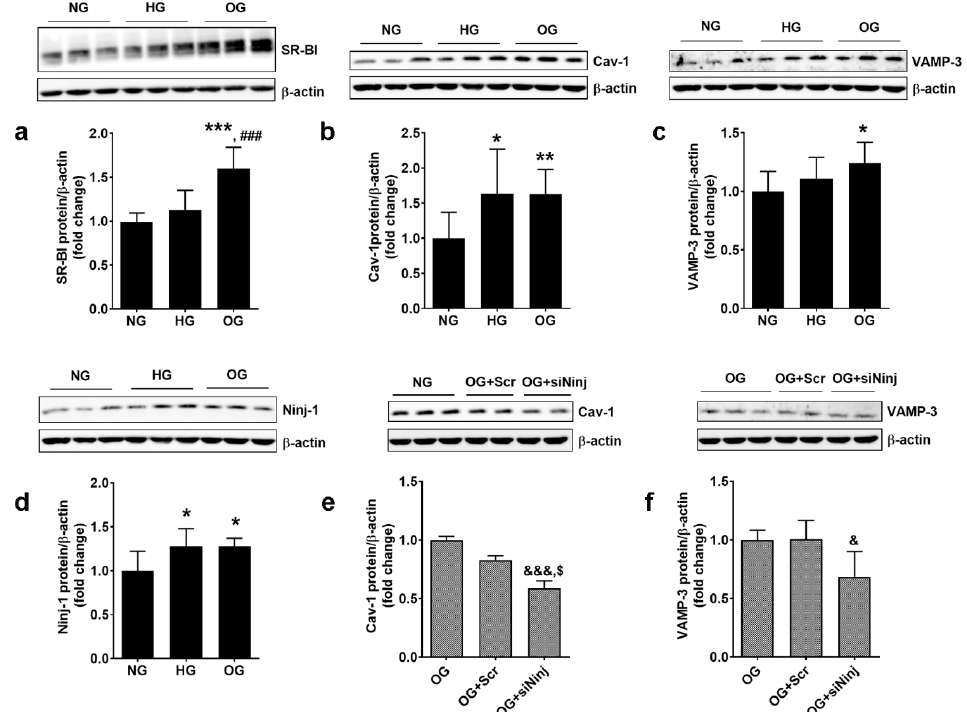
Figure 10. Oscillating glucose stimulates the expression of transendothelial proteins through mech- anisms involving Ninjurin-1 in primary ECs (HUVECs). Cells were exposed alternatively to 5 mM/25 mM glucose (OG) at every 3 h, for 72 h ( a – d ). In some experiments, 24 h before OG exposure, HUVECs were transfected with specific siRNA for NINJ-1 (siNinj) or a scrambled siRNA (Scr). At 24 h after transfection, cells were exposed alternatively to 5 mM/25 mM glucose (OG) at every 3 h, for 72 h ( e , f ). Protein expression of SR-B1 ( a ), Cav-1 ( b , e ), VAMP-3 ( c , f ) and Ninj-1 ( d ) in cells’ lysates relative to β -actin (representative blot and densitometric analysis). All data are expressed as fold change versus NG ( a – d ) or OG ( e , f ) and presented as mean ± SD. * p < 0.05, ** p < 0.01, *** p < 0.001 for OG vs. NG; & p < 0.05, &&& p < 0.001 for siNinj vs. OG; ### p < 0.001; $ p < 0.05 for siNinj vs. OG +